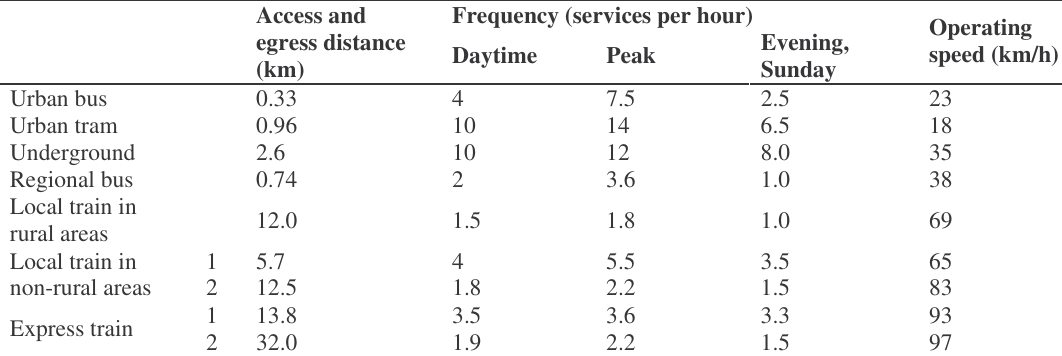
Table 3. Level of service of the Dutch public transport systems in 1990